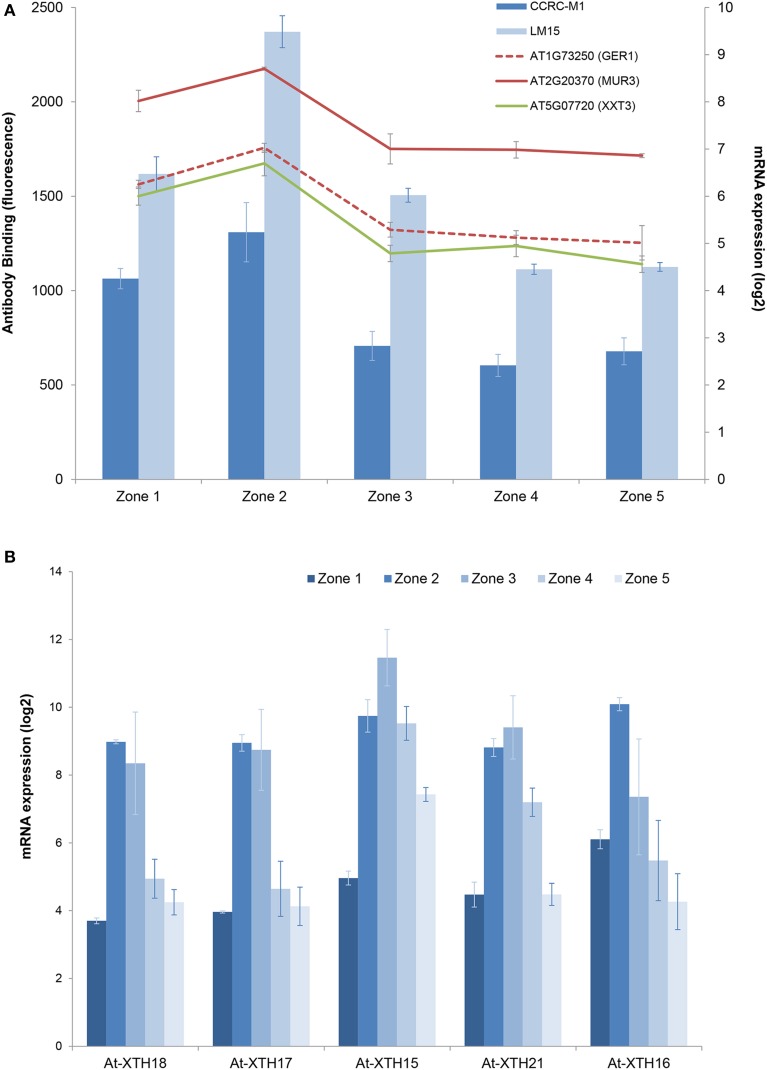
Combined xyloglucan, XyG biosynthesis genes, and XTH expression profiles. (A) epitomic (columns) and XyG biosynthesis mRNA expression (lines). (B) zonal transcriptomic expression profiles for selected members of the XTH family. Error bars are ±1 SD.